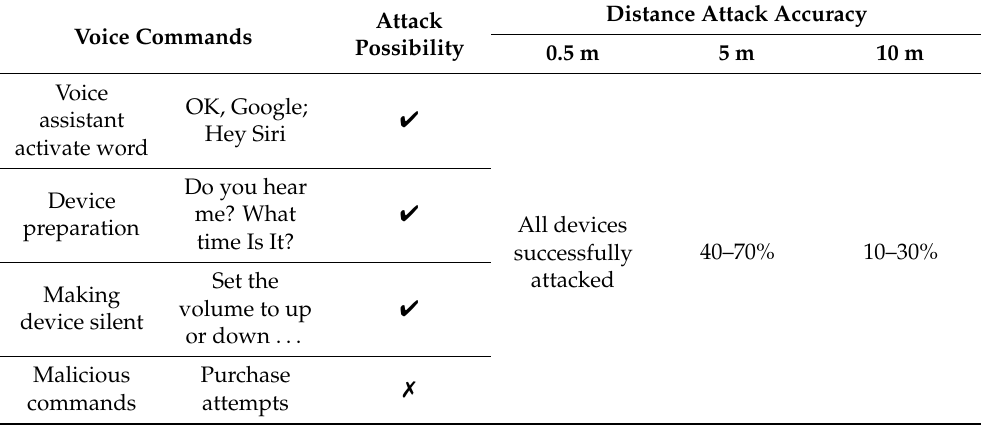
Table 5. Each command’s ability to accurately measure distance.